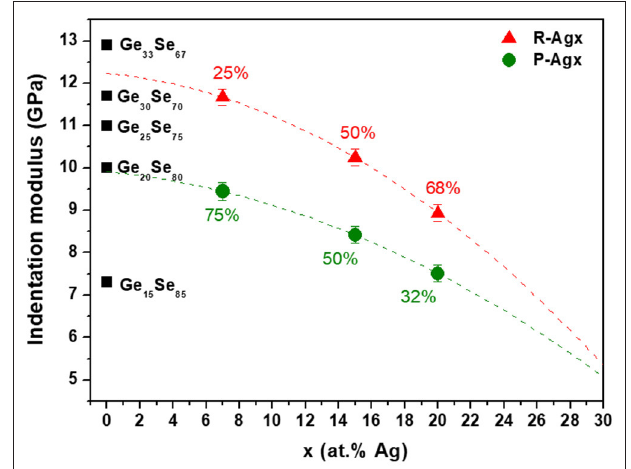
FIGURE 8 | Indentation moduli for R-Agx (red symbols) and P-Agx (green symbols) phases in Ag x (Ge 0.25 Se 0.75 ) 100 − x glasses and for Ge y Se 100 − y glasses (black symbols). Percentages correspond to the proportion of R-Agx and P-Agx phases for each composition Agx. The broken lines are drawn as guides for the